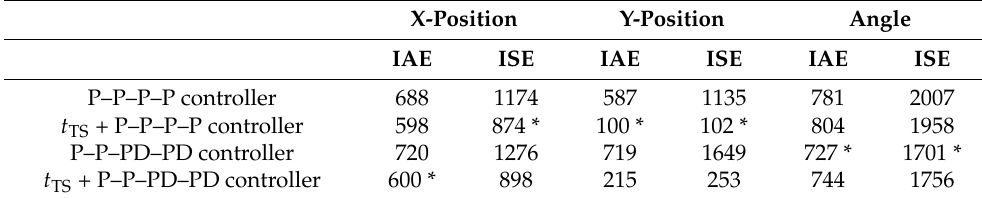
Table 3. IAEs and ISEs by each controller in tracking of ∞ -shaped trajectory.